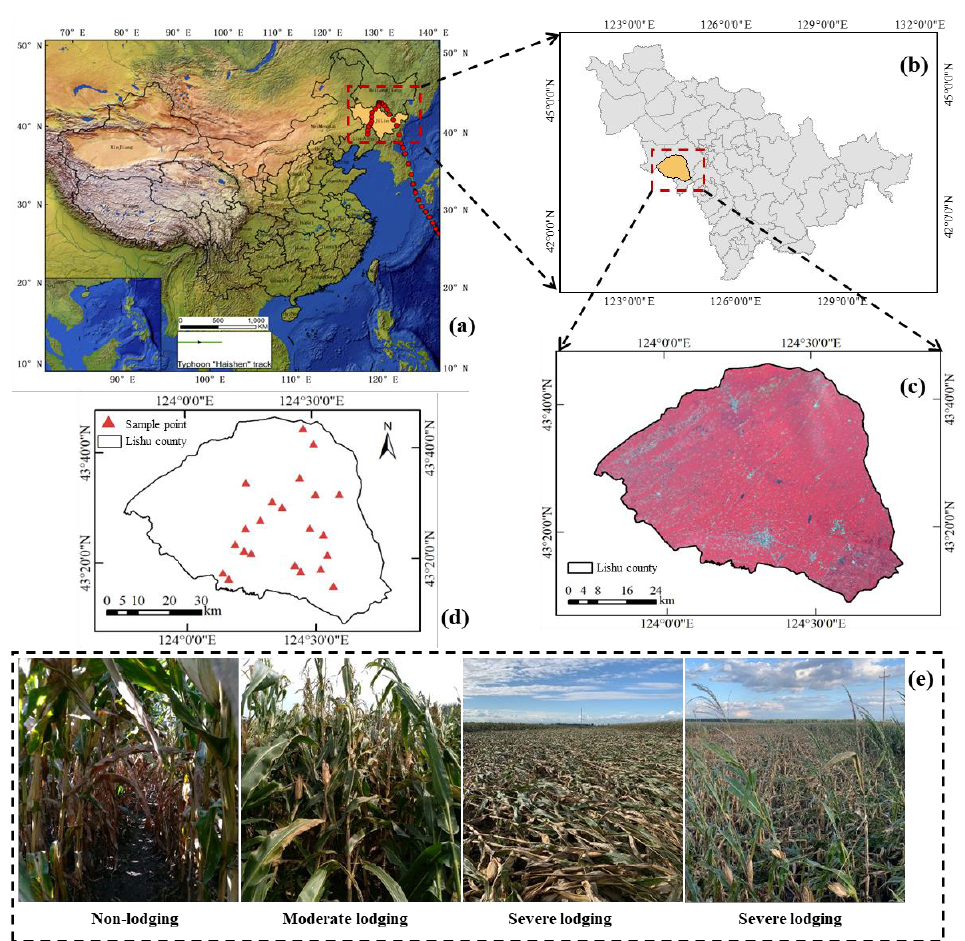
Figure 1. The study area ( a , b ), mosaic GF-1 PMS image ( c ) acquired before the typhoon (R: Band1, G: Band2, B: Band3), location of measured plots ( d ), and photographs ( e ) taken during a field campaign.